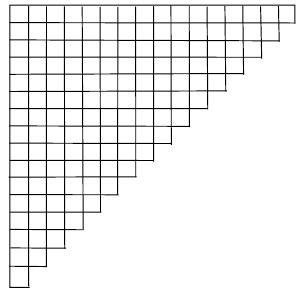
Figure 3 . A microstate in the superstar ensemble is a triangular tableau, here shown for ! = 1. ij @ where (cid:25) 1 ; (cid:25) 2 i (cid:25) 1 @ j (cid:25) 2 are the classical Poisson brackets in the one-particle phase PB = (cid:15) f g space. Thus, in the ~ 0 limit, ^ u generates the Poisson algebra on phase space. !